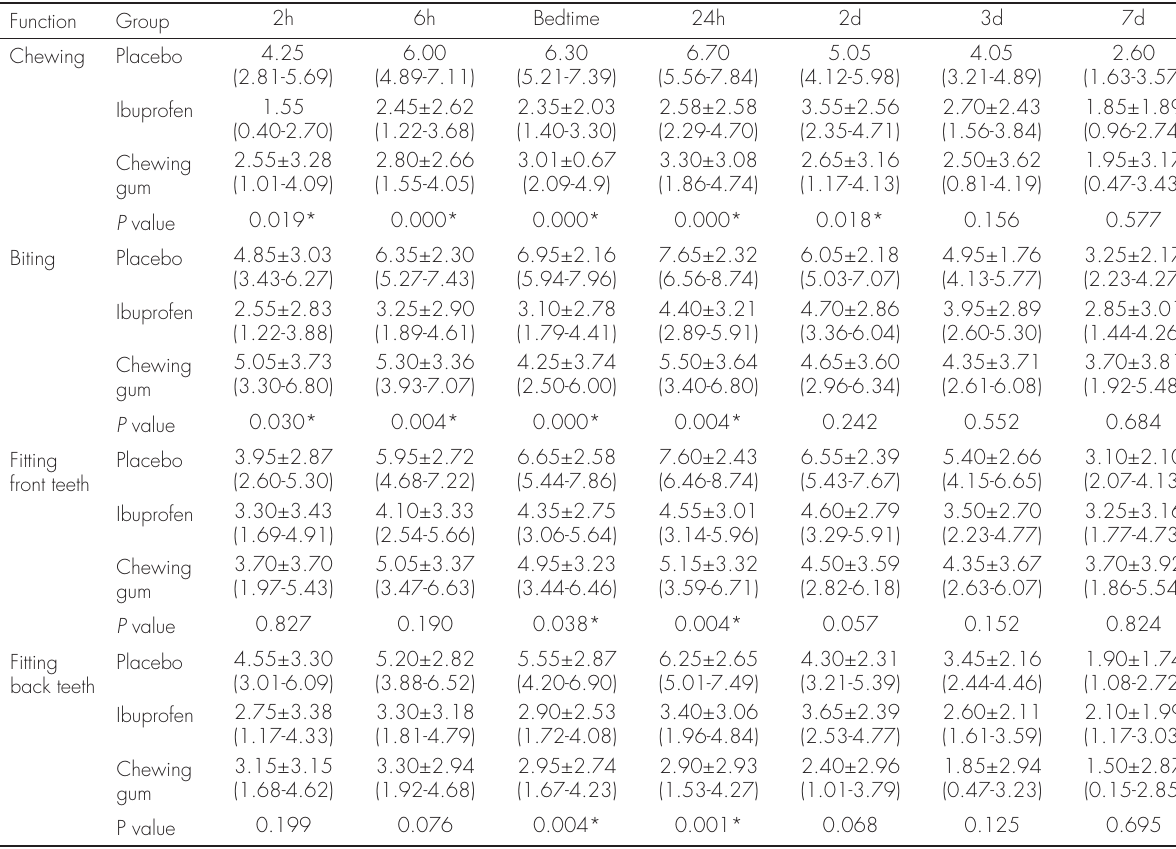
Table II. Descriptive statics for the three groups and repeated measures ANOVA